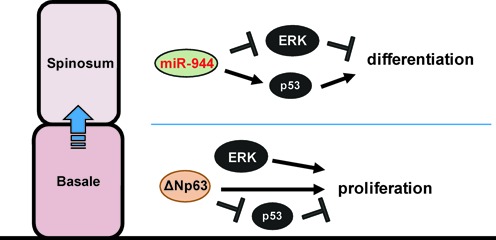
Schematic model of miR-944 biogenesis and function. At the basal layer, ΔNp63 maintains the proliferation of keratinocytes. Moreover, highly active ERK signaling also play a role in proliferation. However, at the spinous layer, ΔNp63 expression is reduced. ΔNp63-induced miR-944 induces cell differentiation. miR-944 functions to reduce ERK signaling and to upregulate p53 expression. These models could explain how ΔNp63 functions in inducing differentiation despite its capacity to maintain proliferation.